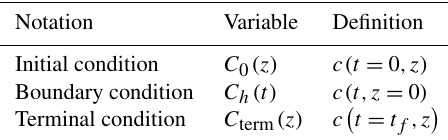
Table 1. Notation used for initial, final, and boundary conditions. In the discrete form, two time steps of the concentration c make up the state vector, x ( t ), and corresponding imposed conditions. Tildes over variables denote